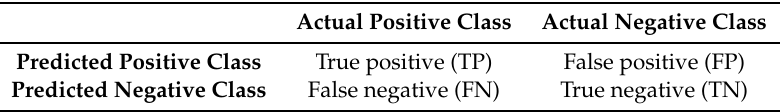
Table 1. Confusion matrix for binary